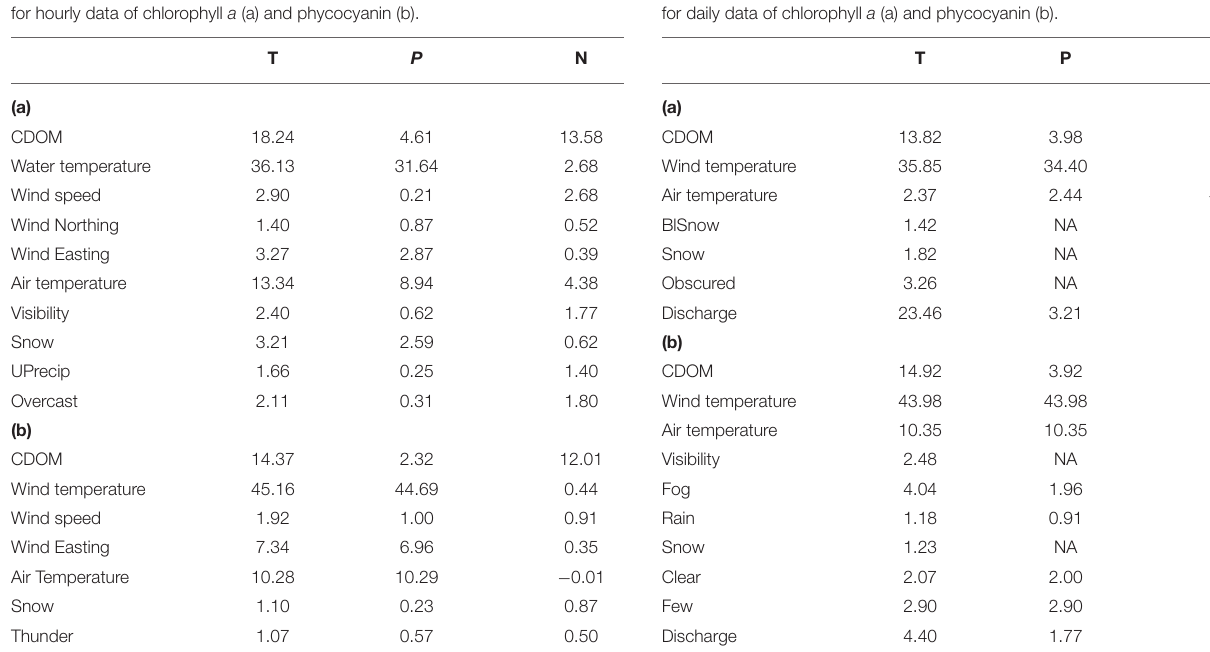
TABLE 3 | Table of adjusted coefficients of multiple determination ( R 2 adj ) associated with the constructed dbMEM variables depending on the